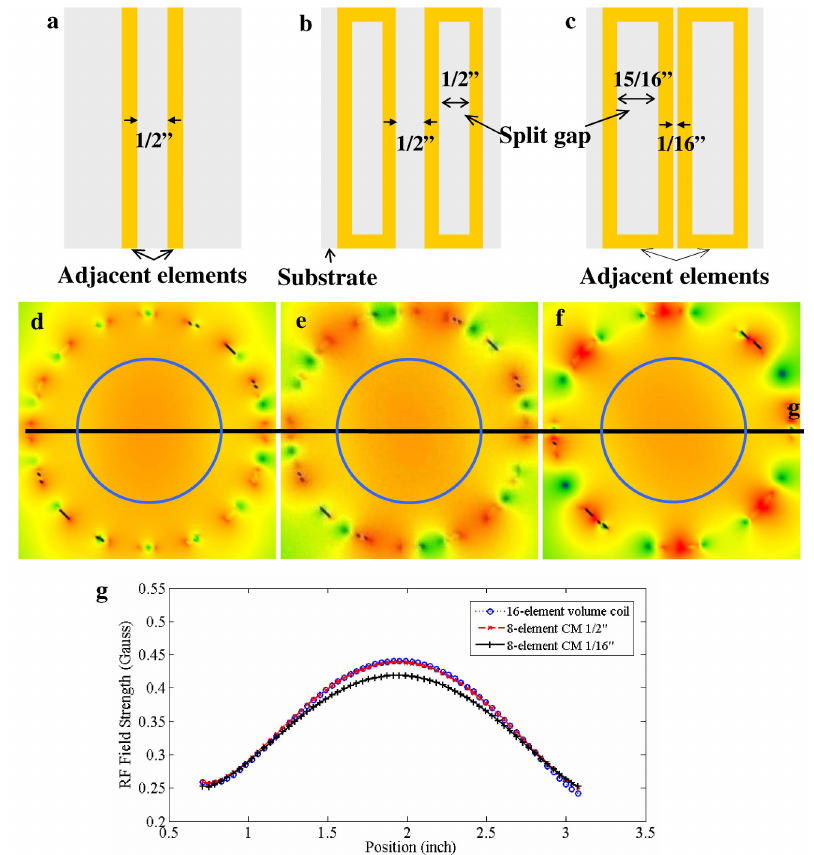
Figure 2. ( a ), ( b ), ( c ) structures of adjacent elements of the typical 16-strut volume coil and two 16-strut common-mode (CM) volume coils with neighboring distance of 1/2 inch and 1/16 inch; ( d ), ( e ), ( f ) the Finite-Difference Time-Domain (FDTD) simulation results of three corresponding models at the central transverse plane; ( g ) 1D profiles of the three magnetic field distribution of the central line. The blue circles in the 2D images denote the area of the 2.4” diameter phantom with permittivity of 58 and conductivity of 0.8 S/m which are close to those of average mouse muscle. The constructive interference of B + pattern on the image is clearly observed. The RF field homogeneity of the CM volume 1 coil is similar to or better than that of a conventional volume coil while the leg number of the CM coil is reduce by half, leading to reduced number of resonant modes. The reduced number of resonant modes helps to simplify the coil design and potentially gain coil